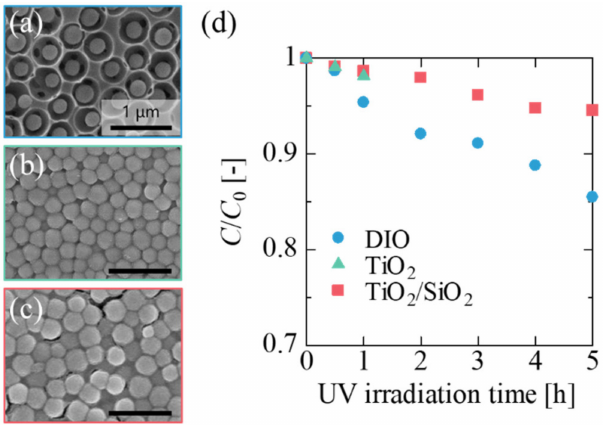
Figure 2. SEM images of ( a ) DIO photocatalytic assembly, ( b ) TiO 2 particle assembly, and ( c ) TiO 2 particle assembly immobilized by SiO 2 frame (TiO 2 /SiO 2 ). ( d ) Photocatalytic activities of DIO assembly, TiO 2 particle assembly, and TiO 2 /SiO 2